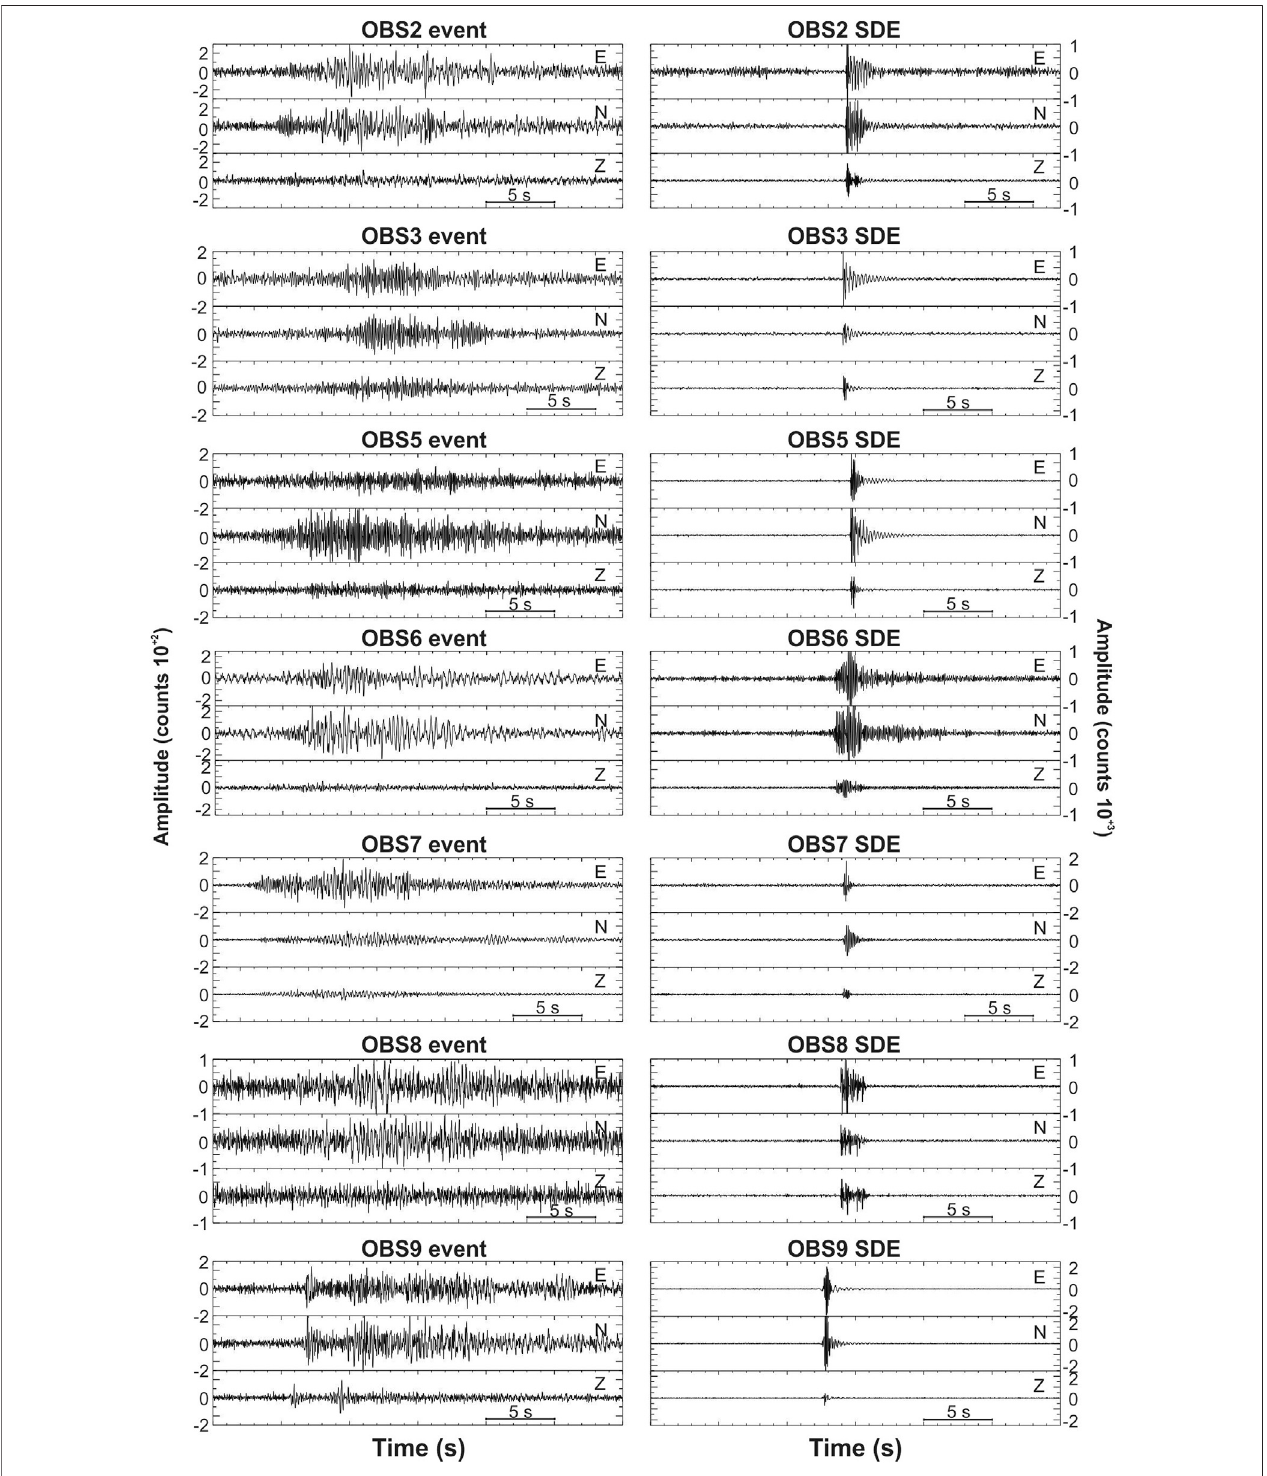
FIGURE10| Comparisonbetweenwaveforms(threecomponents)ofearthquakes (left) andSDEs (right) recordedatthesingleOBS.Timewindowis30 slongfor both signals and all records were fi ltered with band-pass Butterworth fi lter in the same frequency range 2 – 25 Hz.